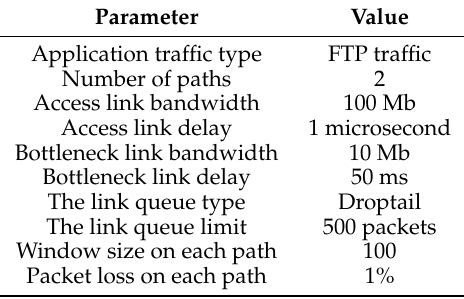
Figure 2. A sample dual dumbbell simulation topology. Table 1. The parameters used in the